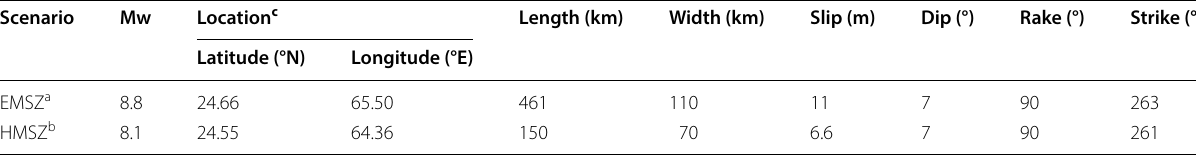
a The Eastern Makran subduction zone scenario b The historical Makran subduction zone earthquake of 27 November 1945